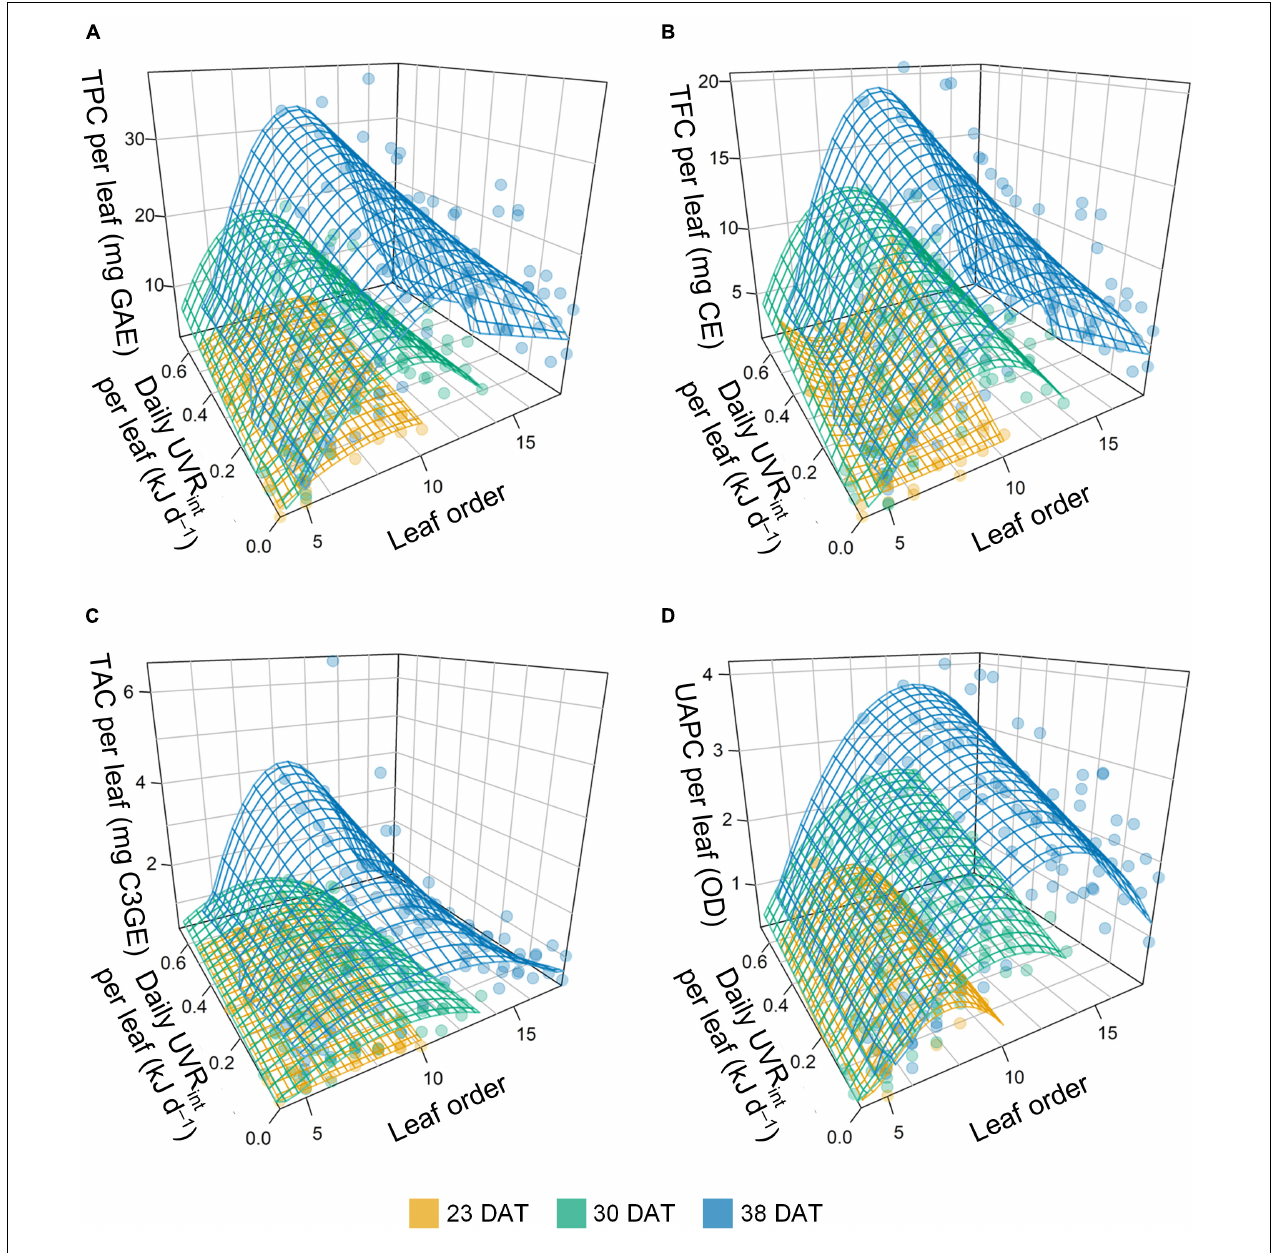
FIGURE 7 | Stepwise multiple linear regression model for phenolic content per leaf of kale plants with daily UV-B radiation interception (UVR int ) per leaf and leaf order at 23, 30, and 38 days after transplanting (DAT): TPC, total phenolic content (A) ; TFC, total flavonoid content (B) ; TAC, total anthocyanin content (C) ; and UAPC, UV-absorbing pigment content (D) . The surfaces were obtained by stepwise multiple regression models referring to Eq. 1 and Table 1 .